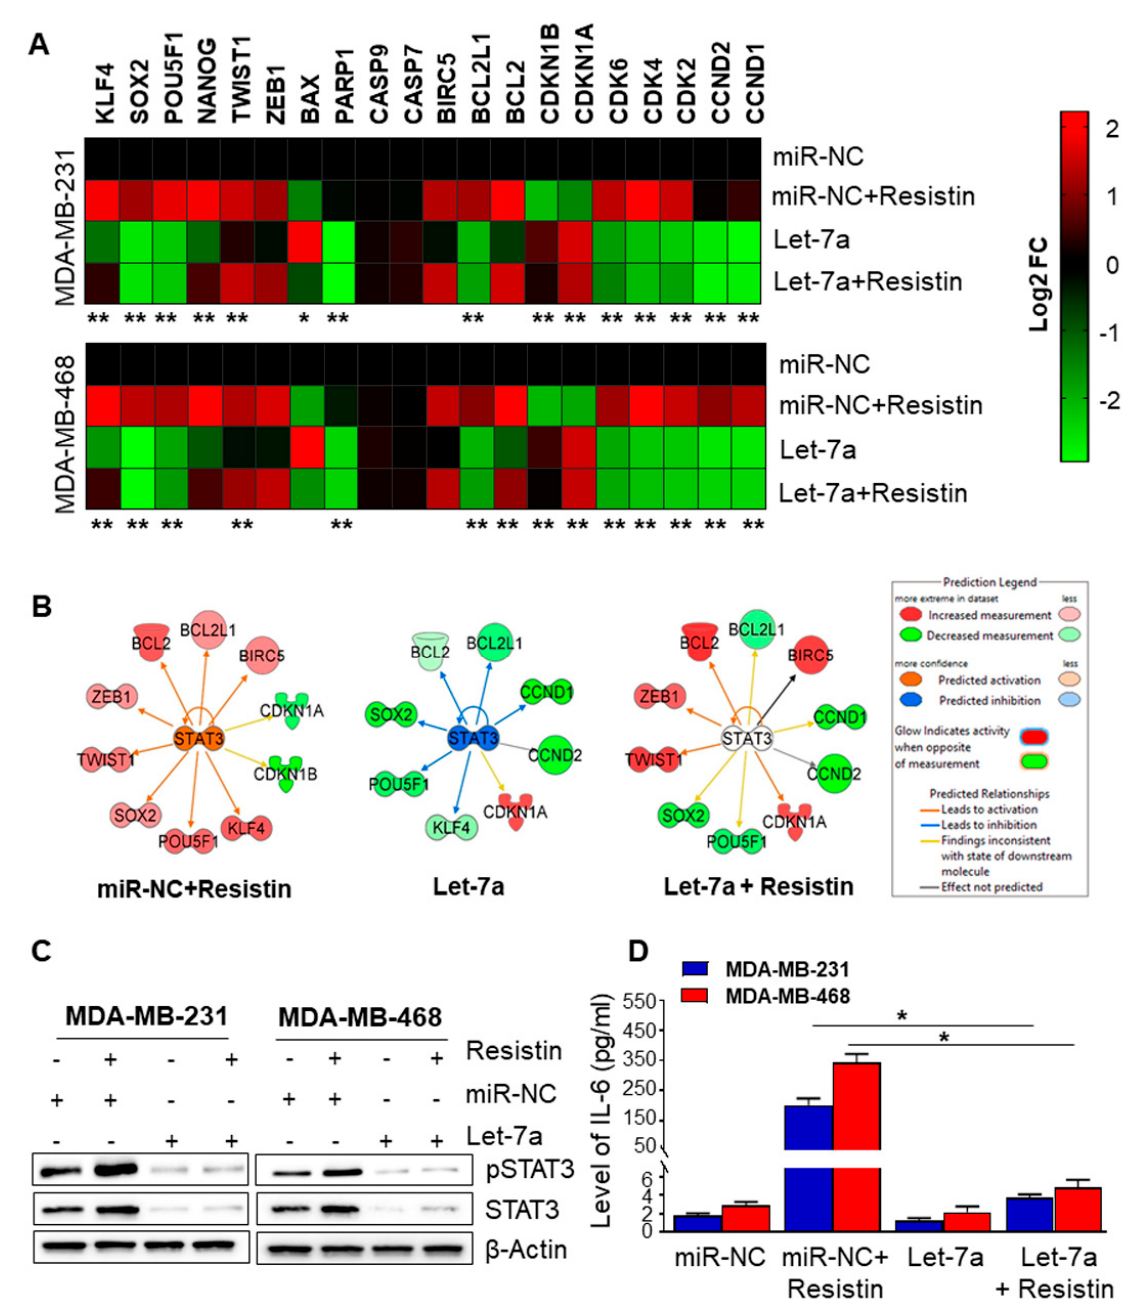
Figure 4. STAT3 activation is associated with resistin-induced, Let-7a-mediated effects on gene expression. ( A ) MDA-MB-231 and MDA-MB-468 cells were transfected with miR-NC or Let-7a mimic for 24 h, treated with resistin (20 ng/mL), and expression of growth, survival, and stemness related genes were analyzed by qRT-PCR. GAPDH was used as an internal control. ( B ) Ingenuity Pathways Analysis was performed to interpret the gene regulatory networks in BC cells after